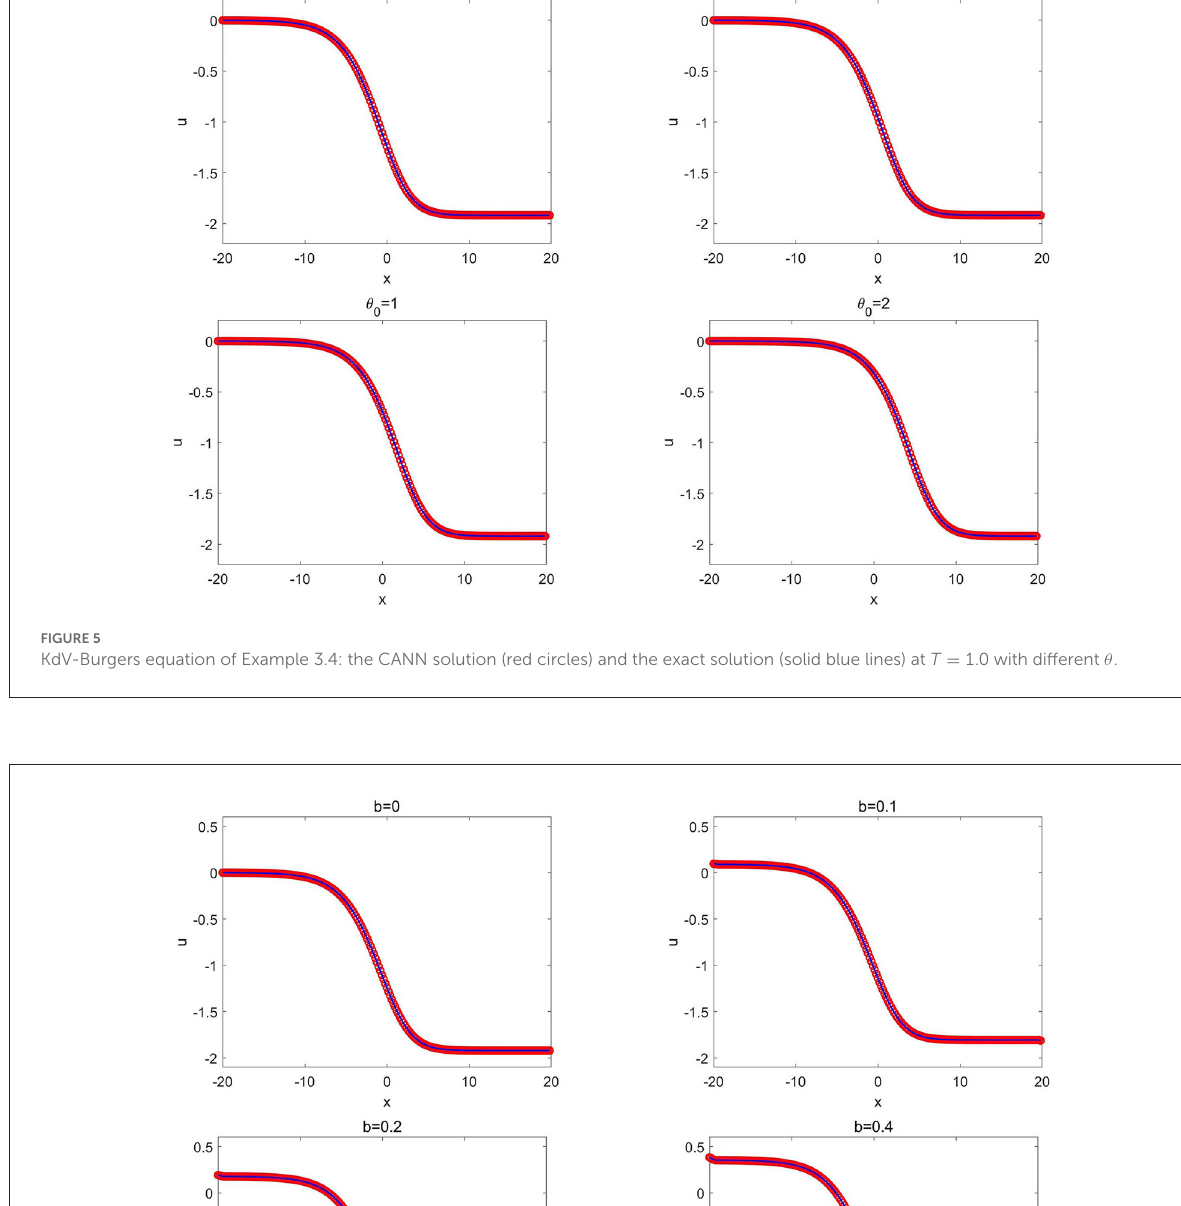
FIGURE6 KdV-Burgers equation of Example 3.4: the CANN solution (red circles) and the exact solution (solid blue lines) at T